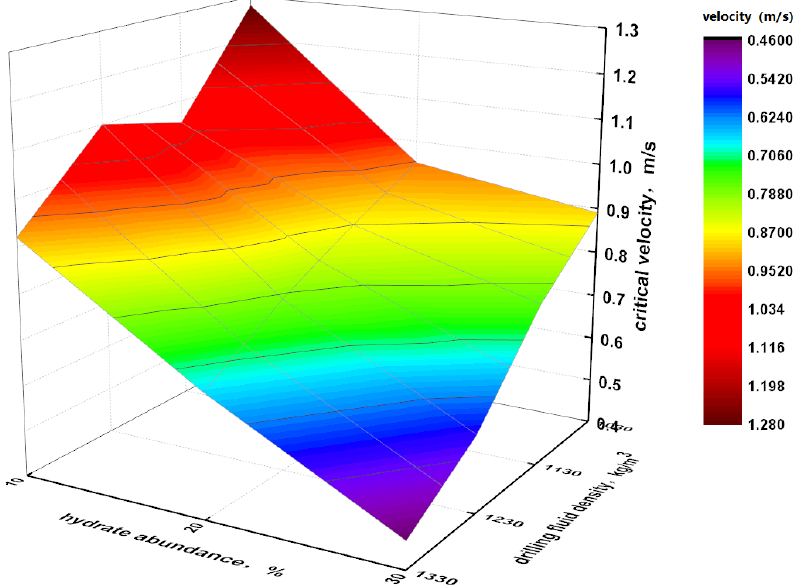
Figure 11. The critical flow velocity plate of different hydrate abundance and drilling fluid density under 45-degree angle expansion.